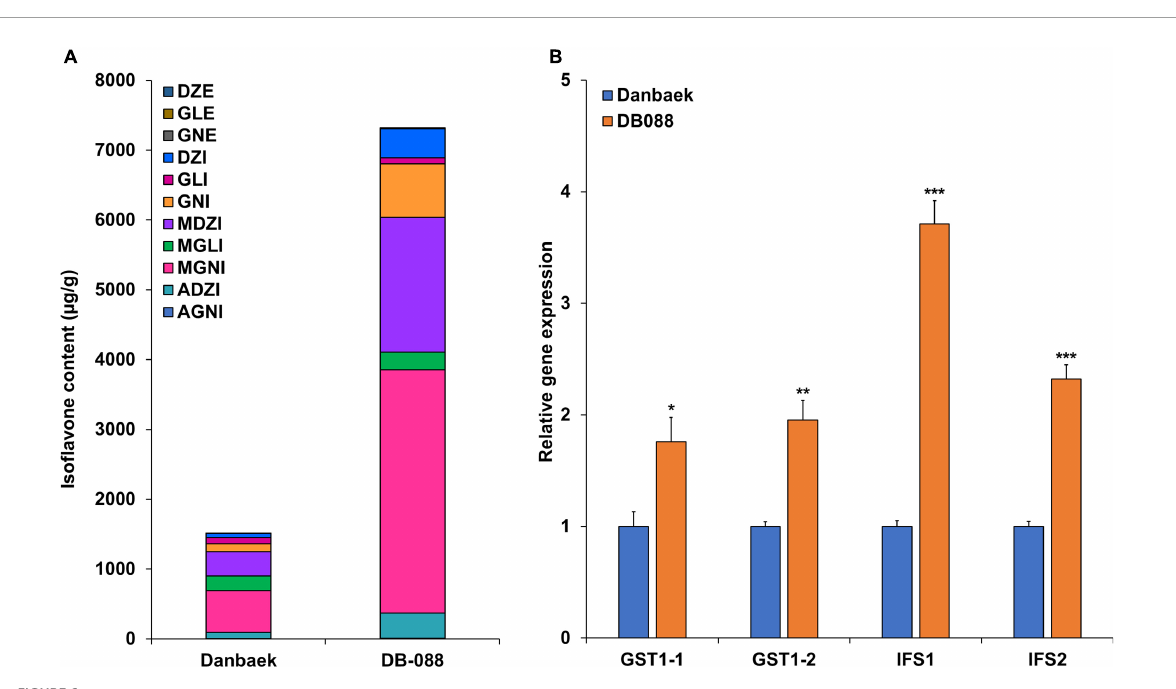
FIGURE6 Transcript levels of GmGSTT1 and other isoflavone biosynthetic genes in original cultivar (DB) and its mutant (DB-088), and isoflavone contents. (A) Isoflavone content in DB and DB-088; (B) relative gene transcript levels in DB and DB-088. All data are means ± SD ( n = 5). The * p < 0.05, ** < 0.01, and ** < 0.001, Student’s t